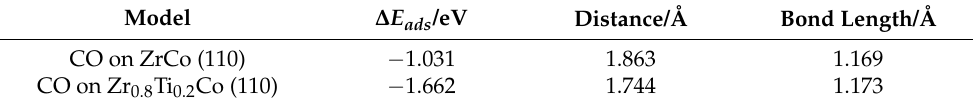
Table 2. Adsorption energy, final adsorption distance, and C-O bond length.